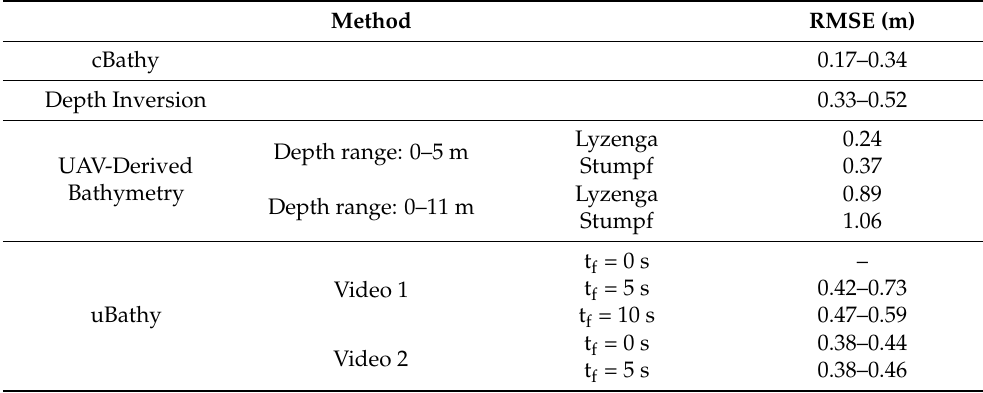
Table 4. Summary of the depth Root Mean Square Error (RMSE) values for the cBathy, Depth Inversion, UAV-Derived Bathymetry (UDB), and uBathy methods. Own study based on [32,33,39,49].